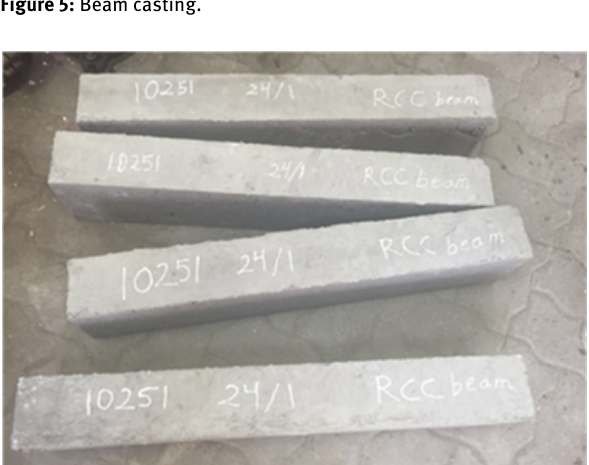
ination. Three rods per beam were used for attaching the mesh with concrete beam. After fixing the nails along with mesh, cement mortar with a ratio 1:2 was used to cover the mesh with the RC beam as shown in figure 8. Steel